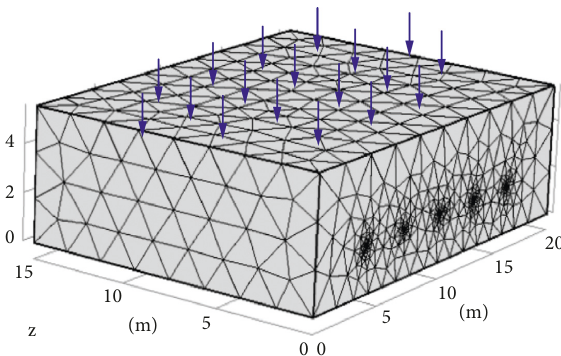
Figure 4: Geometry model and boundary